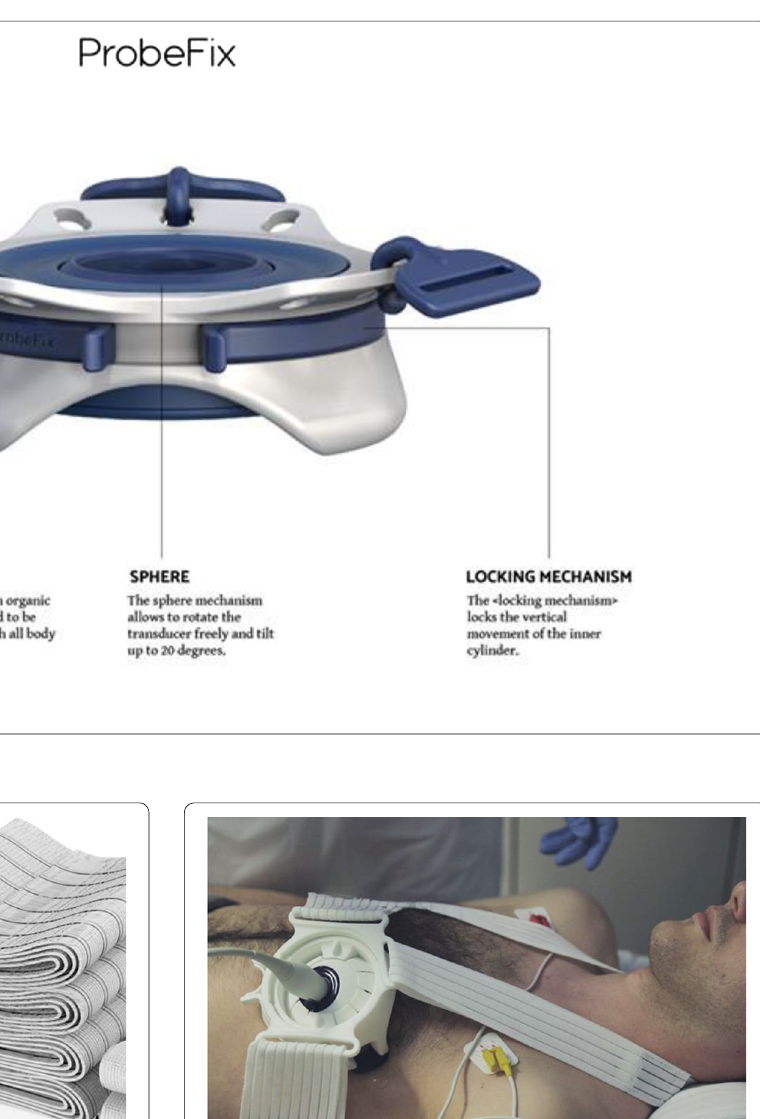
Fig. 3 Example of the fixation of the Probefix on a